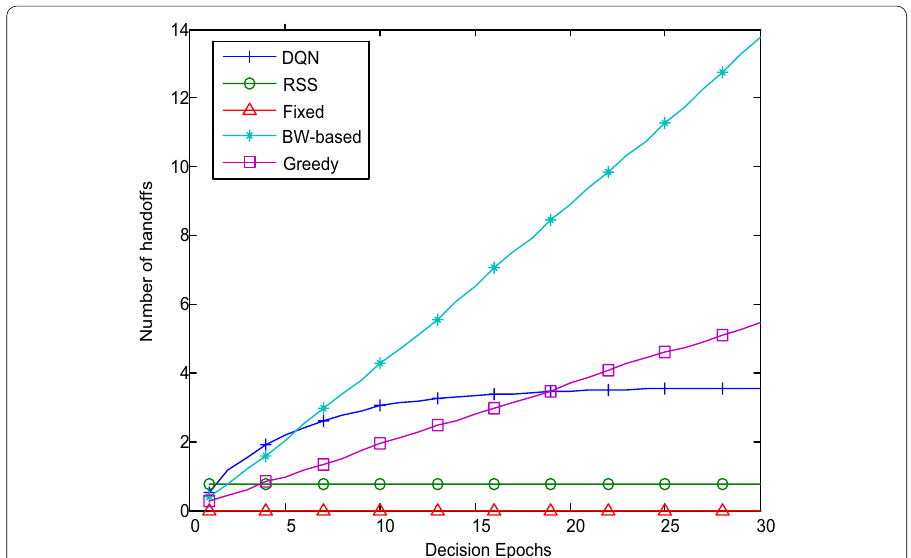
compared to the RSS